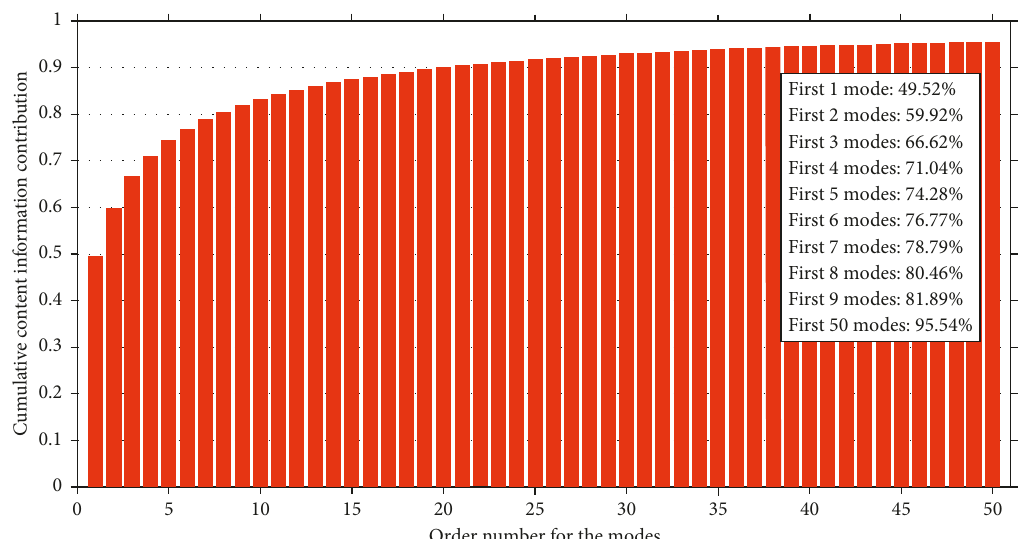
Figure 12: Cumulative content information contribution for the first 50 modes in the initial stage of flame propagation.